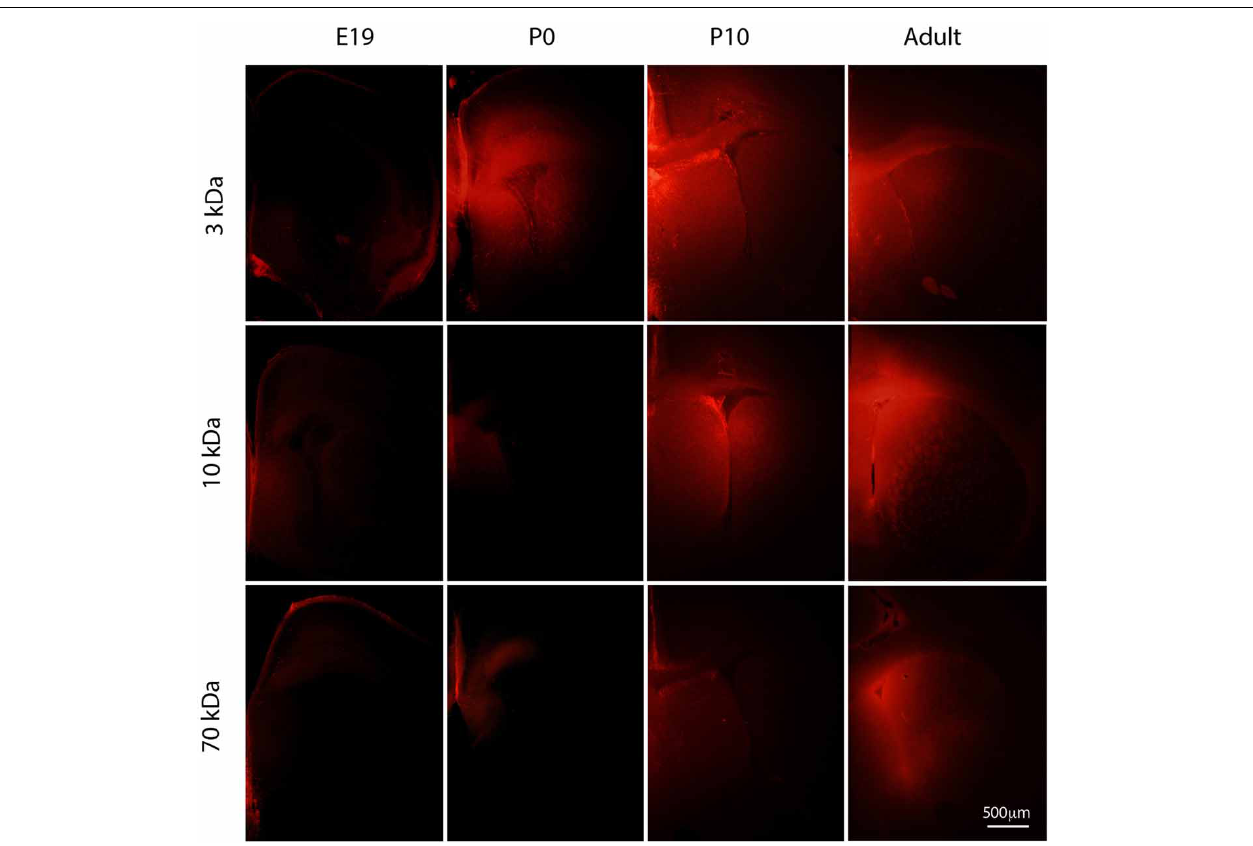
FIGURE 3 | Diffusion of different sized rhodamine labeled biotinylated dextrans (BDA) into postnatal mouse brain. Vibratome coronal sections (80 μ m thick) through cortex of mice injected with different sized BDAs (3, 10, and 70kDa). Markers were injected into the contralateral ventricle and left to diffusefor2–3minatE19andP0,5minatP10and10minintheadult.Notethat